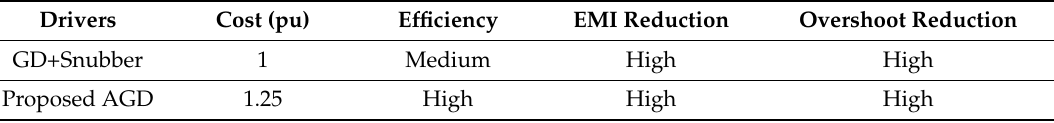
Table 4. Cost and characteristic